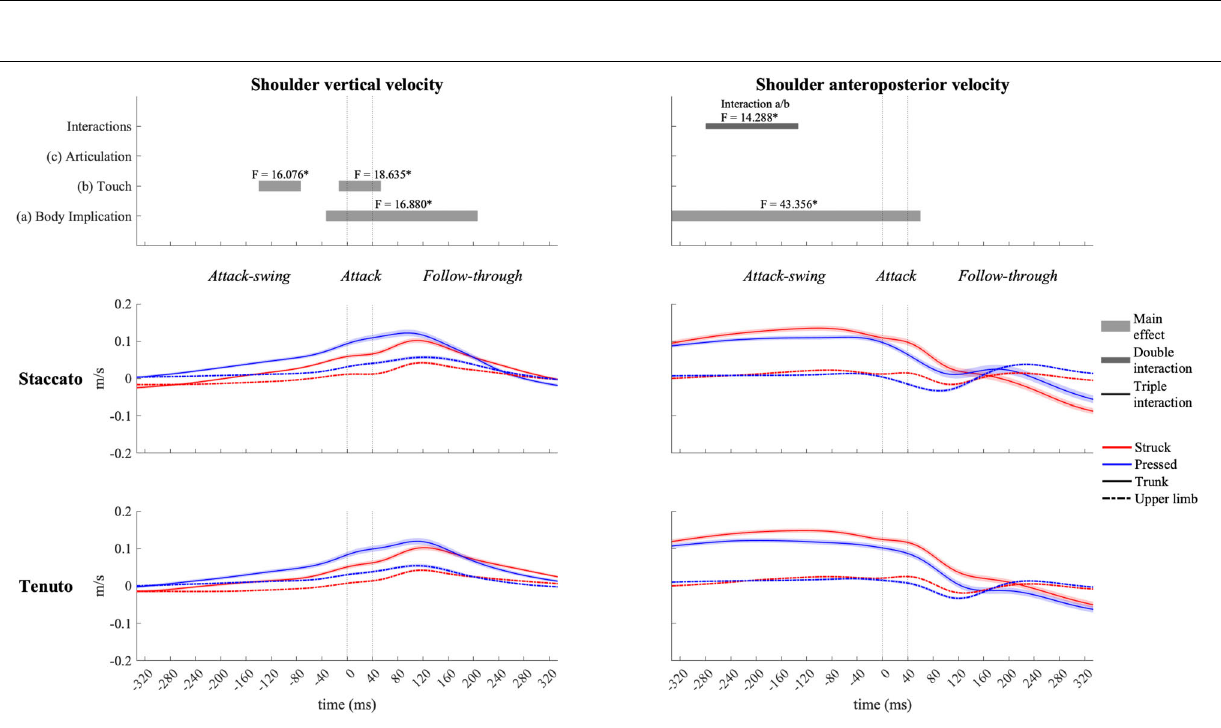
FIGURE 6 | Mean values (solid and dash-dotted lines) and 95% bootstrap confidence interval (shaded areas) of elbow linear velocities during the three phases of the keystroke. Negative/positive values indicate downward/upward velocities and backward/forward velocities. Top panels represent the results from the statistical parametric mapping of time-series values. * p -value ≤ 0.001.